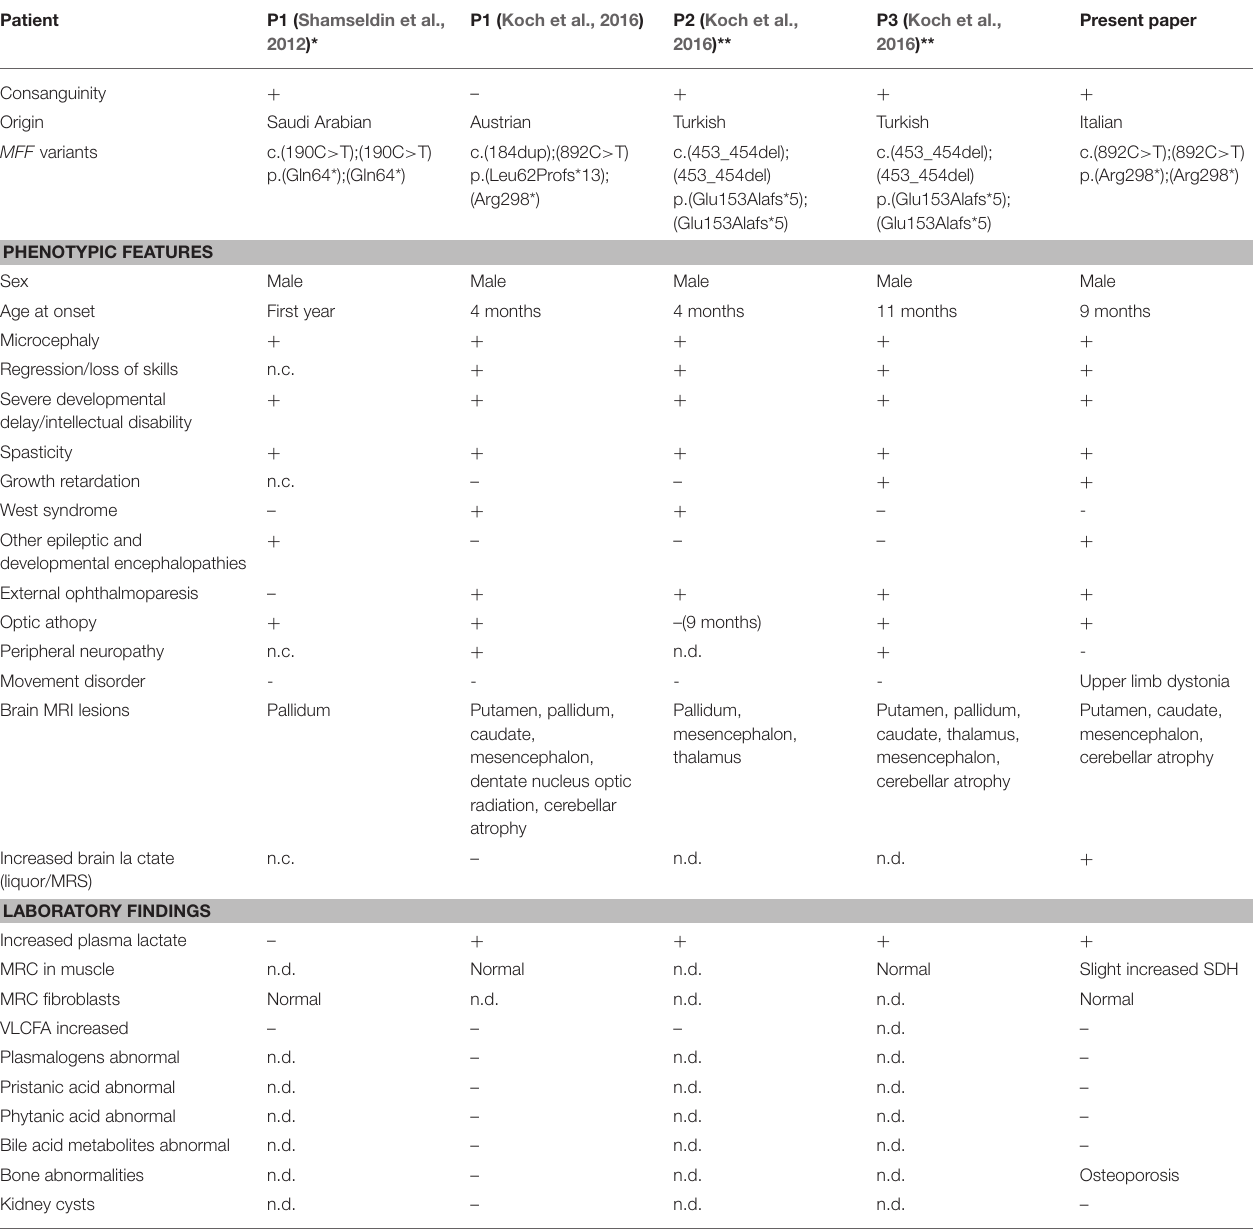
TABLE 1 | Genetic findings and biochemical and phenotypic features of published cases with MFF mutations.